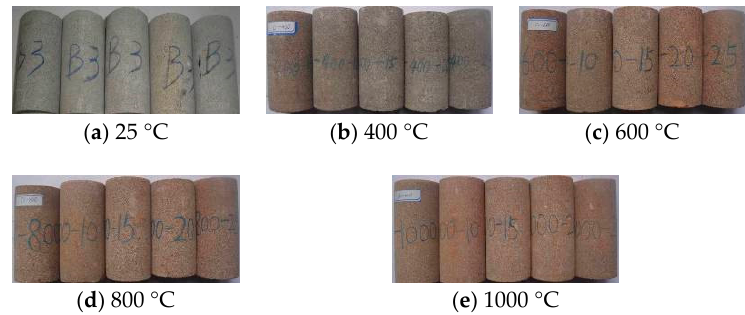
Figure 2. Group B samples at different temperature.